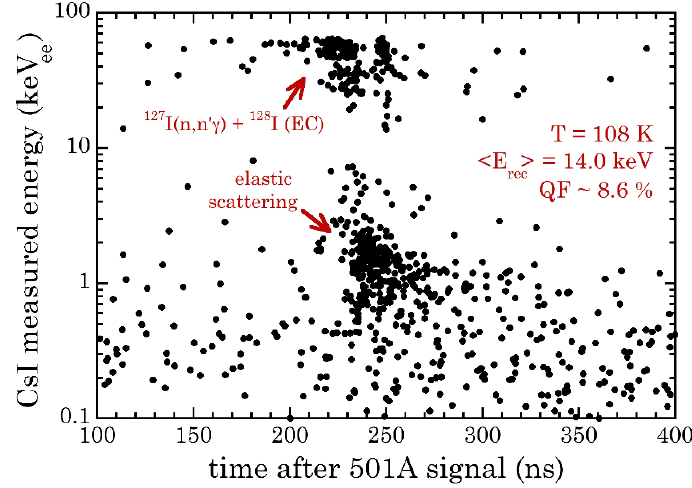
Figure 5 . First measurement of nuclear recoil quenching factor (QF) for cryogenic CsI. The (cid:12)gure displays the measured electron-equivalent energy (keV ee ) deposited by 14 keV Cs and I nuclear recoils induced by 2.2 MeV neutron scattering. The reader is referred to a similar (cid:12)gure 2 in [71], for more details on the methodology employed in QF